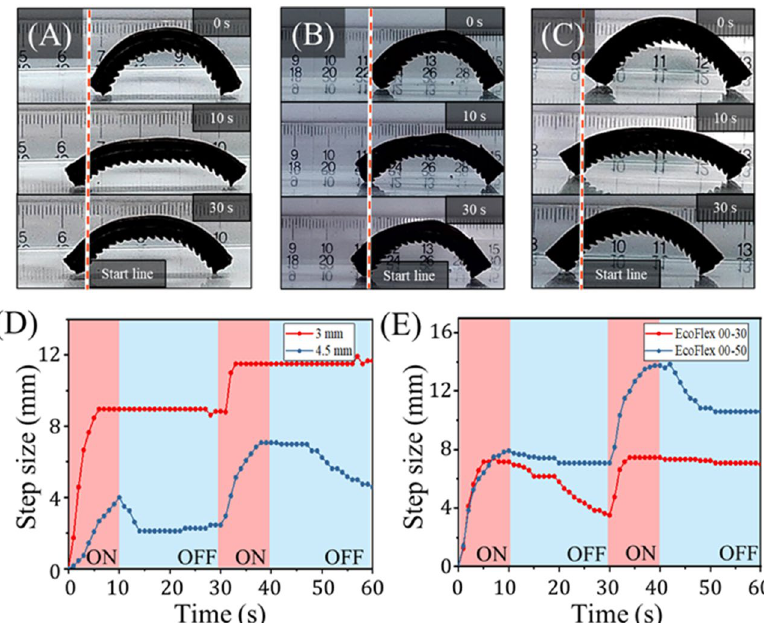
Figure 7. Analysis of mag-bot with different skin parameters. ( A–C ) Snapshots of mag-bots with 30° pattern angles are shown at (top) 0 s (before actuation), (middle) 10 s (at the end of one extension cycle), and (bottom) 30 s (at the end of one complete cycle). The mag-bot in ( A ) has 4.5 mm-thick skin comprised of EcoFlex 00-30 for comparison to the control design (3 mm-thick skin comprised of EcoFlex 00-30). The mag-bot in ( B ) has 4 mm-thick EcoFlex 00-30 skin, and the mag-bot in ( C ) has 4 mm-thick EcoFlex 00-50 skin. ( D ) Net forefoot displacement is plotted with respect to time for the control magbot from Fig. 6A, and mag-bot of ( A ). ( E ) Net forefoot displacement is plotted with respect to time for the mag-bots of ( B,C